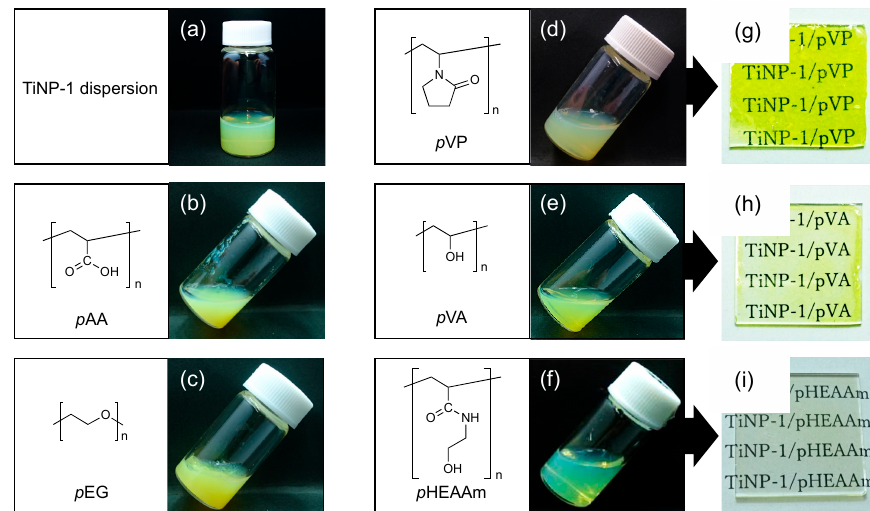
Figure 2. Photos of the aqueous dispersion of TiNP-1 ( a ), aqueous mixtures of TiNP-1 and the water-soluble polymers (( b ): p AA, ( c ): p EG, ( d ): p VP, ( e ): p VA, ( f ): p HEAAm), and the composite films (( g ): p VP, ( h ): p VA, ( i ): p HEAAm) prepared by casting of the aqueous mixture on a glass plate at 10 ◦